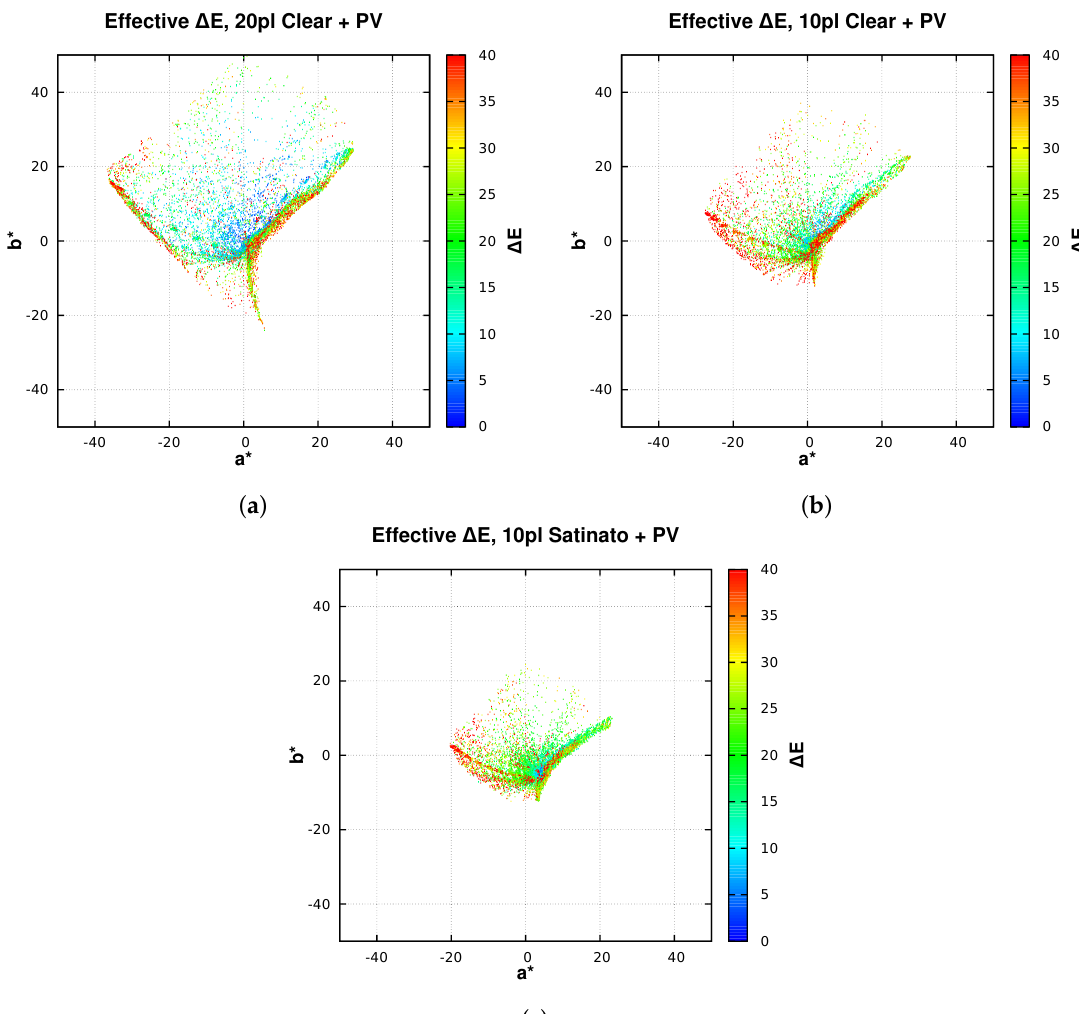
Figure 7. Colour difference ∆ E between effective printed and nominal colours in L*a*b* space for 20 pl ( a ) and 10 pl ( b ) on clear glass, and 10 pl on satinated glass ( c ). The locations of the points correspond to the effective printed